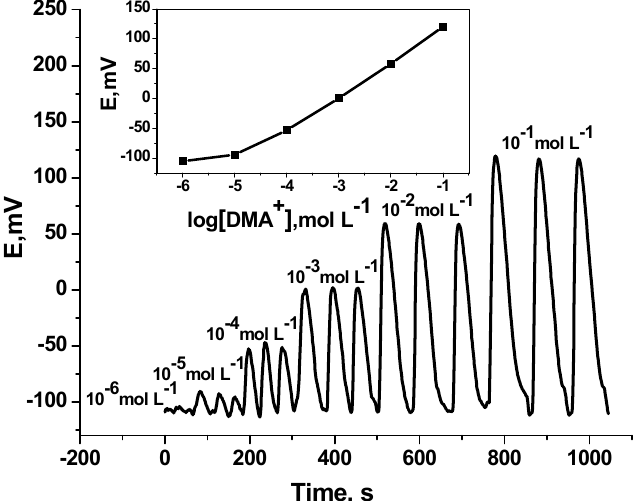
Figure 5. Transient flow injection signals of DMA sensor. Flow conditions: carrier solution, 5.0 mmol·L − 1 Trizma buffer (pH 7.1); flow rate 3.5 mL min − 1 ; loop volume 200 µL .